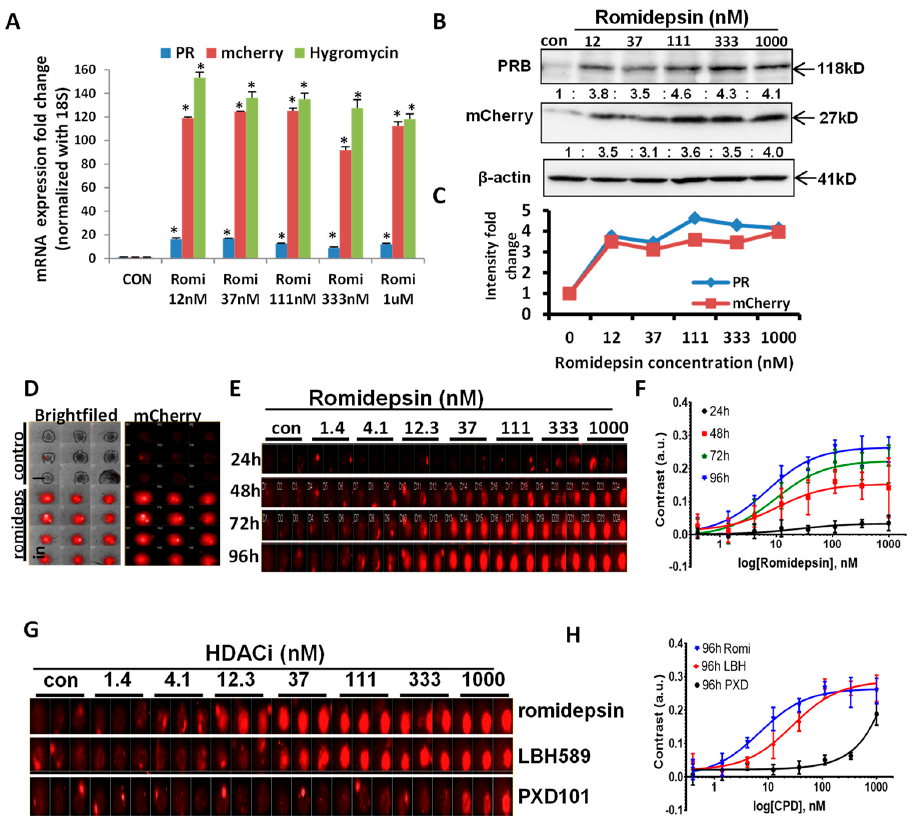
Figure 2. Confirming the correlation of mCherry and PR expression after HDAC inhibitor stimula- tion. ( A ) mRNA expression of PR, mCherry, and hygromycin were increased simultaneously upon romidepsin treatment for 24 h at 12 nM, 37 nM, 111 nM, 333 nM, and 1 µM. ( B ) Romidepsin treat- ment increased PR and mCherry protein expression at the indicated concentration. ( C ) Quantifica- tion of PR and mCherry fold changes in Figure 2B. ( D ) Red mCherry fluorescent signal represents PR expression after 1µM romidepsin treatment (in triplicate) in 3D spheroid cultured Ishikawa cells for 72 h. ( E ) Dosage response (1.4 nM to1000 nM) and time course (24–96 h) experiments represent the gradually increased mCherry signal by romidepsin triplicate treatment. ( F ) The time-dependent dose responses of Romidepsin. The contrasts of mCherry fluorescence from individual spheroids were utilized for the mCherry expression increase. ( G ) Multiple HDACi triplicate treatments in- creased mCherry signal with the indicated dose and time course. ( H ) The dose responses of three compounds (Romidepsin, LBH589, and PXD101) at 96 h after treatment. The contrasts of mCherry fluorescence from individual spheroids were utilized for the mCherry expression increase. * p < 0.05 vs. control. 3.3. Screen for and Validate Potential PR Inducers One valuable advantage of using this endogenous PR reporter gene is the ability to screen for potential PR inducers from drug libraries. Through this method, new FDA drugs that can restore functional PR expression and further sensitize endometrial cancer cells to progestin therapy can be identified. The FDA-approved 1018 drug library was applied to PR reporter gene expressing cells, followed by monitoring the mCherry signal, which represents endogenous PR expression, as previously verified. After two rounds of screening, 20 initial FDA drugs with increased mCherry signal were chosen; representa- tive mCherry signals are shown in Figure 3A. All screening datasets were summarized in Figure 3B. Both the scatter plot and histograms of controls and screening FDA-approved drug library were presented for the hits for spheroid killing/inhibition and mCherry ex- pression. The hit drugs with significant mCherry expression were then further tested over ten concentrations, ranging from 30 µM to 0.5 nM (example images shown in Figure S2).